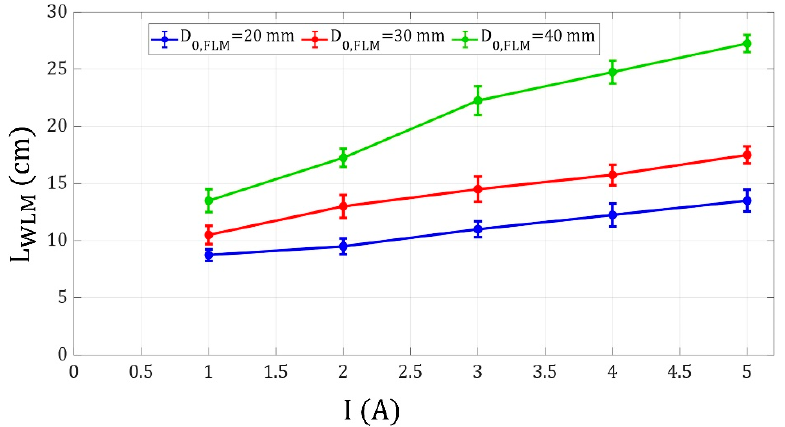
Figure 9. WLM shooting distance versus FLM volume for FLM initial distances of 20, 30, and 40 mm from the electromagnet, WLM volume and initial distance of 30 μ L and 0 mm from the electromagnet, respectively, and coil current of 3 A.